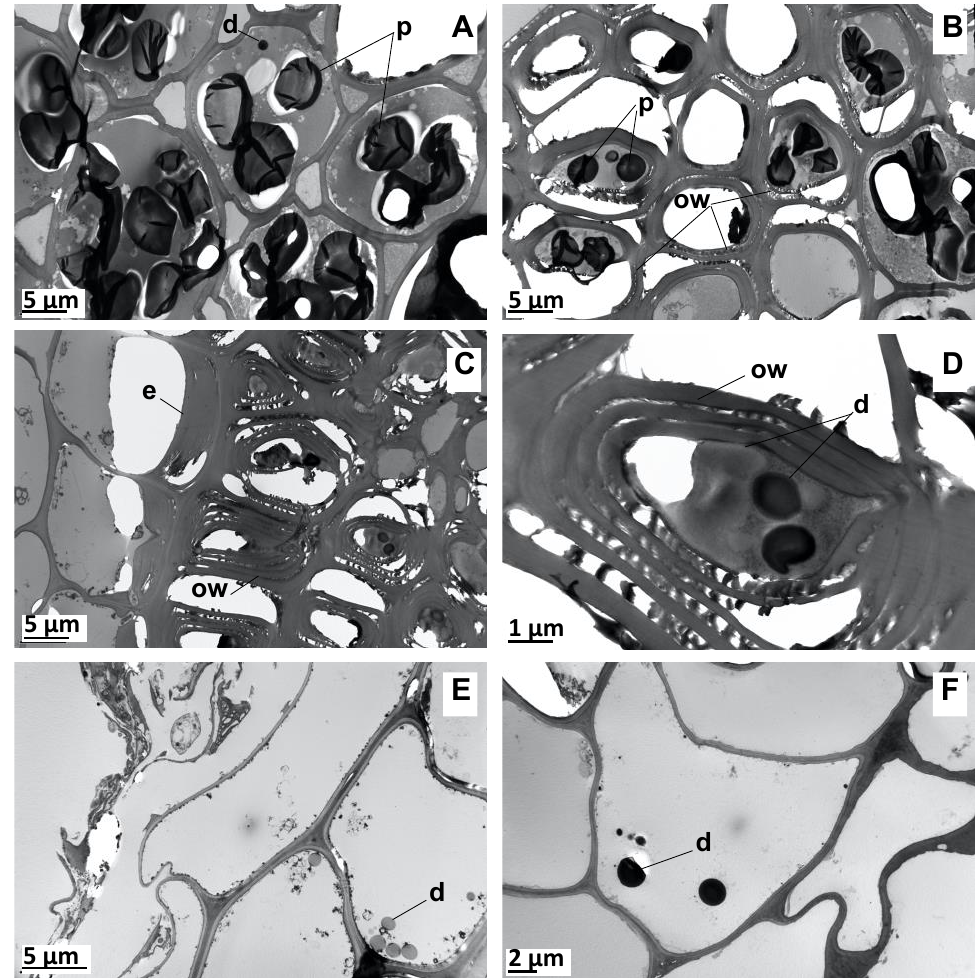
Figure 4. Transmission electron microscopy (TEM) of vetiver root grown in potting soil. ( A , B ) Woody parenchyma cells of the central cylinder. ( C , D ) Endoderm and adjacent tissue. ( E , F ) Cortical parenchyma cells. d: EO droplet; e: endoderm; ow: onion peel-like structure of the cell wall; p: essential oil (EO) pocket.